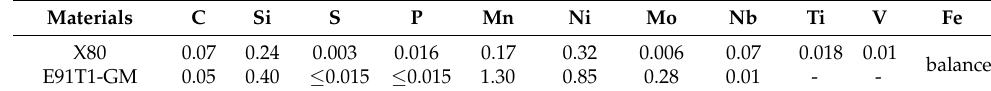
Table 1. Chemical composition (wt.%) of X80 pipeline steel and flux-cored wire.